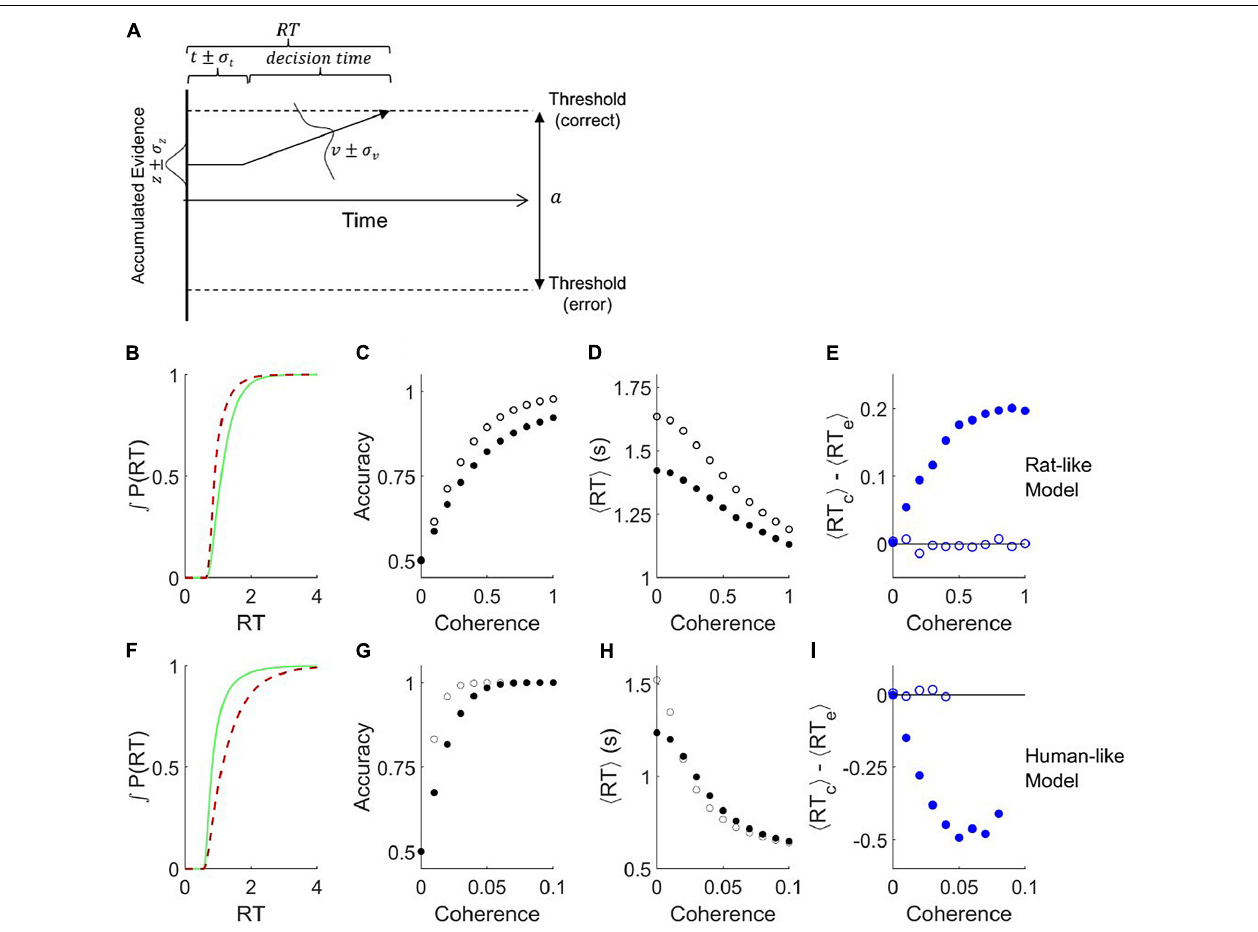
FIGURE 2 | Addition of variability to the parameters of the drift diffusion model. (A) Definition of parameters. The parameter a is the distance between the error and correct thresholds. The starting point of evidence accumulation is given by z . The average drift rate v depends on the stimulus strength. The observable outcomes are response time (RT) and decision (correct or error). The non-decision-time t reflects both sensory latency and motor latency, but is drawn at left for graphical simplicity. Parameters t , z , and v vary from trial to trial according to the variability parameters σ t , σ z , and σ v , respectively. Drift rate variability was simulated by a normal distribution around the mean parameter. Starting point variability and non-decision time variability were simulated by uniform distributions centered on the mean parameter. Diagram after (Ratcliff and McKoon, 2008). (B–E) Analysis of trials simulated with parameters that produce qualitatively rat-like behavior: a = 1 . 84, t = 0 . 74, σ v = 0 . 1, σ z = 1 . 5, σ t = 0 . 2, and v = − 0 . 5 c 2 + 2 . 5 c , where c is coherence (motion stimulus strength). (B) Cumulative probability distributions of correct vs. error trial response times, for c = 0 . 8. (C) Psychometric curve. (D) Chronometric curve. (E) Difference between mean response times of errors and correct trials. (F–I) Like panels (B–E) but with parameters that produce qualitatively human-like behavior: a = 2 . 0, t = 0 . 5, σ v = 1 . 5, σ z = 0 . 3, σ t = 0 . 03, and v = − 80 c 2 + 80 c . (F) Cumulative RT probability distributions for c = 0 . 03. For all these simulations, the mean starting point z = 0, timestep τ = 0 . 001, diffusion noise σ n = 1, N = 10 5 trials per coherence. Open symbols show results obtained after setting σ z = 0 and σ v = 0. Note that in conditions with 100% accuracy the (cid:104) RT c (cid:105) − (cid:104) RT e (cid:105) difference is